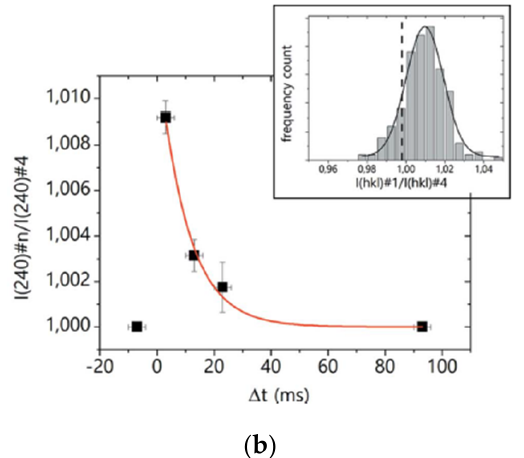
Figure 10. ( a ) Structures of the ground (left) and metastable (right) states of sodium nitroprusside. ( b ) Normalized intensity of the 240 reflection as a function of time, together with the histogram of the normalized intensity distribution obtained for this reflection. Figure reproduced with permission of the International Union of Crystallography from Casaretto et al. [85] .